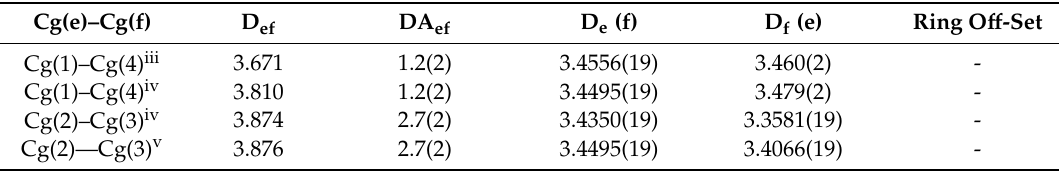
Table 3. Geometry-related parameters of cyclic face-to-face stacking interactions for HBPAH with